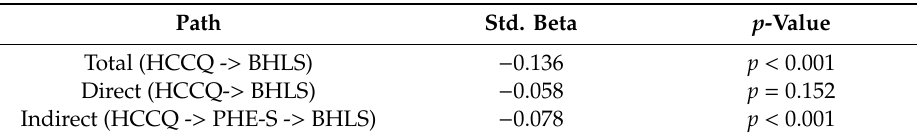
Table 6. Total, direct, and indirect effects of HCCQ on BHLS.